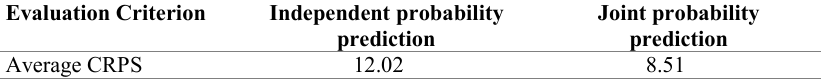
Table 1. Evaluation criterion of two kinds of probability prediction results